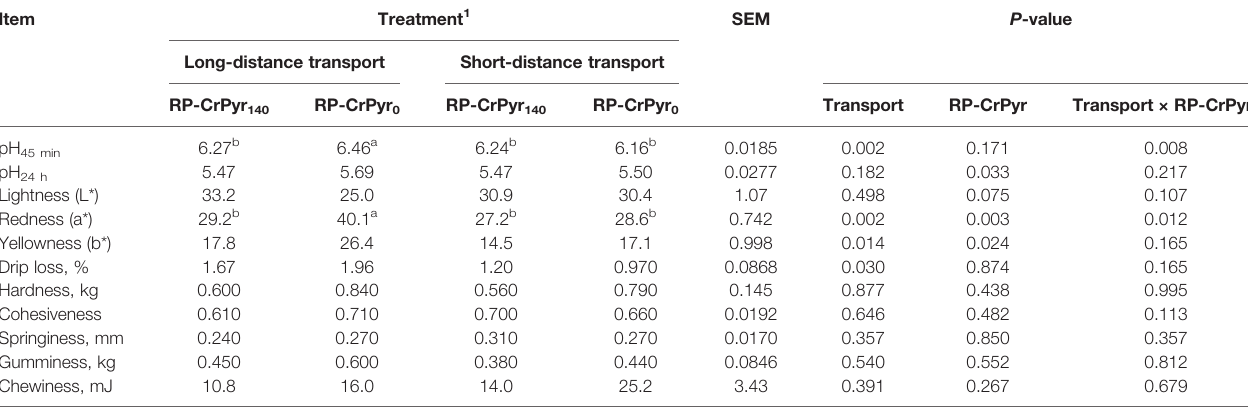
TABLE 3 | Effects of transport and rumen-protected creatine pyruvate on the M. longissimus thoracis meat quality of beef cattle. Item Treatment 1